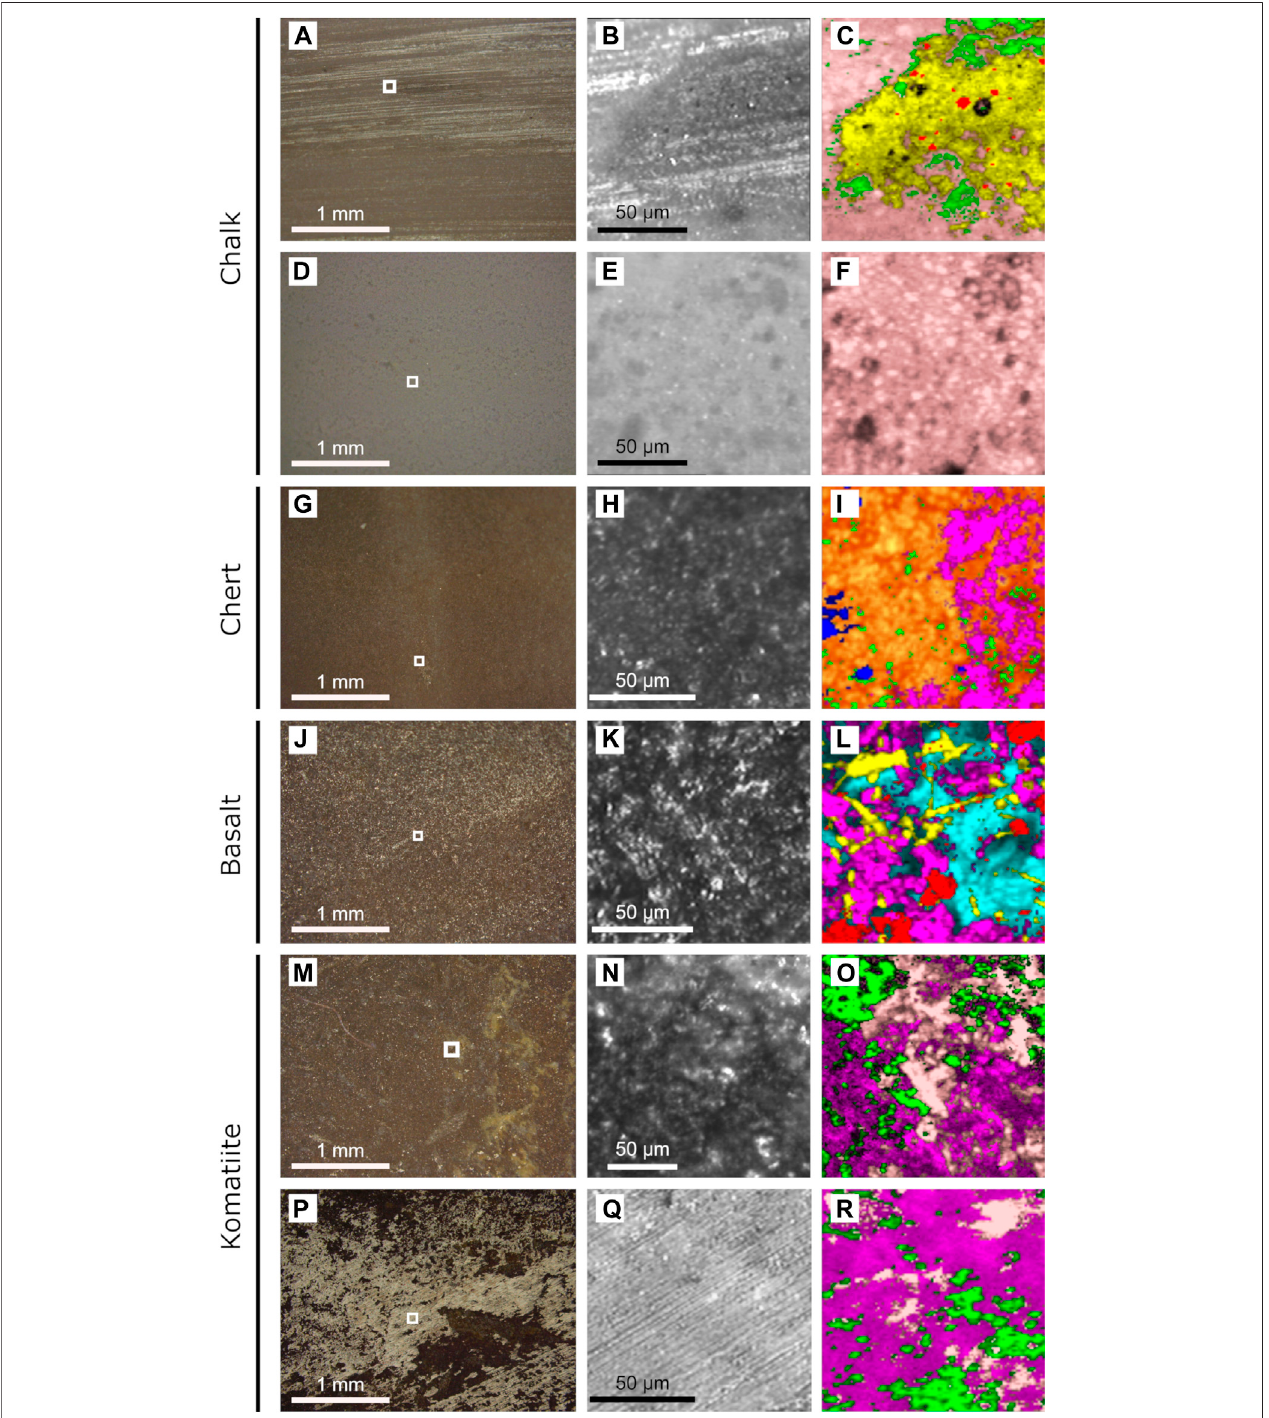
FIGURE 10 | Ramananalysesofthesamplesaftercutting.Foreachsample,theanalysedareaisdenotedbyasmallwhitesquareinthere fl ectedlightmicrographontheleft. (A,B) re fl ected light optical microscopy images of the indurated area of the chalk sample. (C) Raman spectroscopy compositional map with calcite in pink, amorphous silica in yellow, carbonaceousmaterialingreen andan unidenti fi edphaseinred. (D,E) re fl ected lightopticalmicroscopy imagesofthenon-indurated areaofthechalksample. (F) Ramanspectroscopy compositional map showing only calcite in pink. (G,H) re fl ected light optical microscopy images of the chert sample (slow cut). (I) Raman spectroscopy compositional map with muscovite in fuchsia, anatase in dark blue, carbonaceous material in green, and quartz in orange. (J,K) re fl ected light optical microscopy images of the basalt sample. (L) Raman spectroscopy compositionalmapwithaugitein fuchsia,labradoriteinlightblue,hematitein red, andapatiteinyellow. (M,N) re fl ectedlightopticalmicroscopyimagesofamattpartofthe komatiitesample. (O) Ramanspectroscopycompositionalmapwithtalcinpink,antigorite(serpentine)infuchsia,andcarbonaceousmaterialingreen. (P,Q) re fl ectedlightopticalmicroscopy images of a bright part of the komatiite sample. (R) Raman spectroscopy compositional map with talc in pink, antigorite (serpentine) in fuchsia, and carbonaceous material in green.